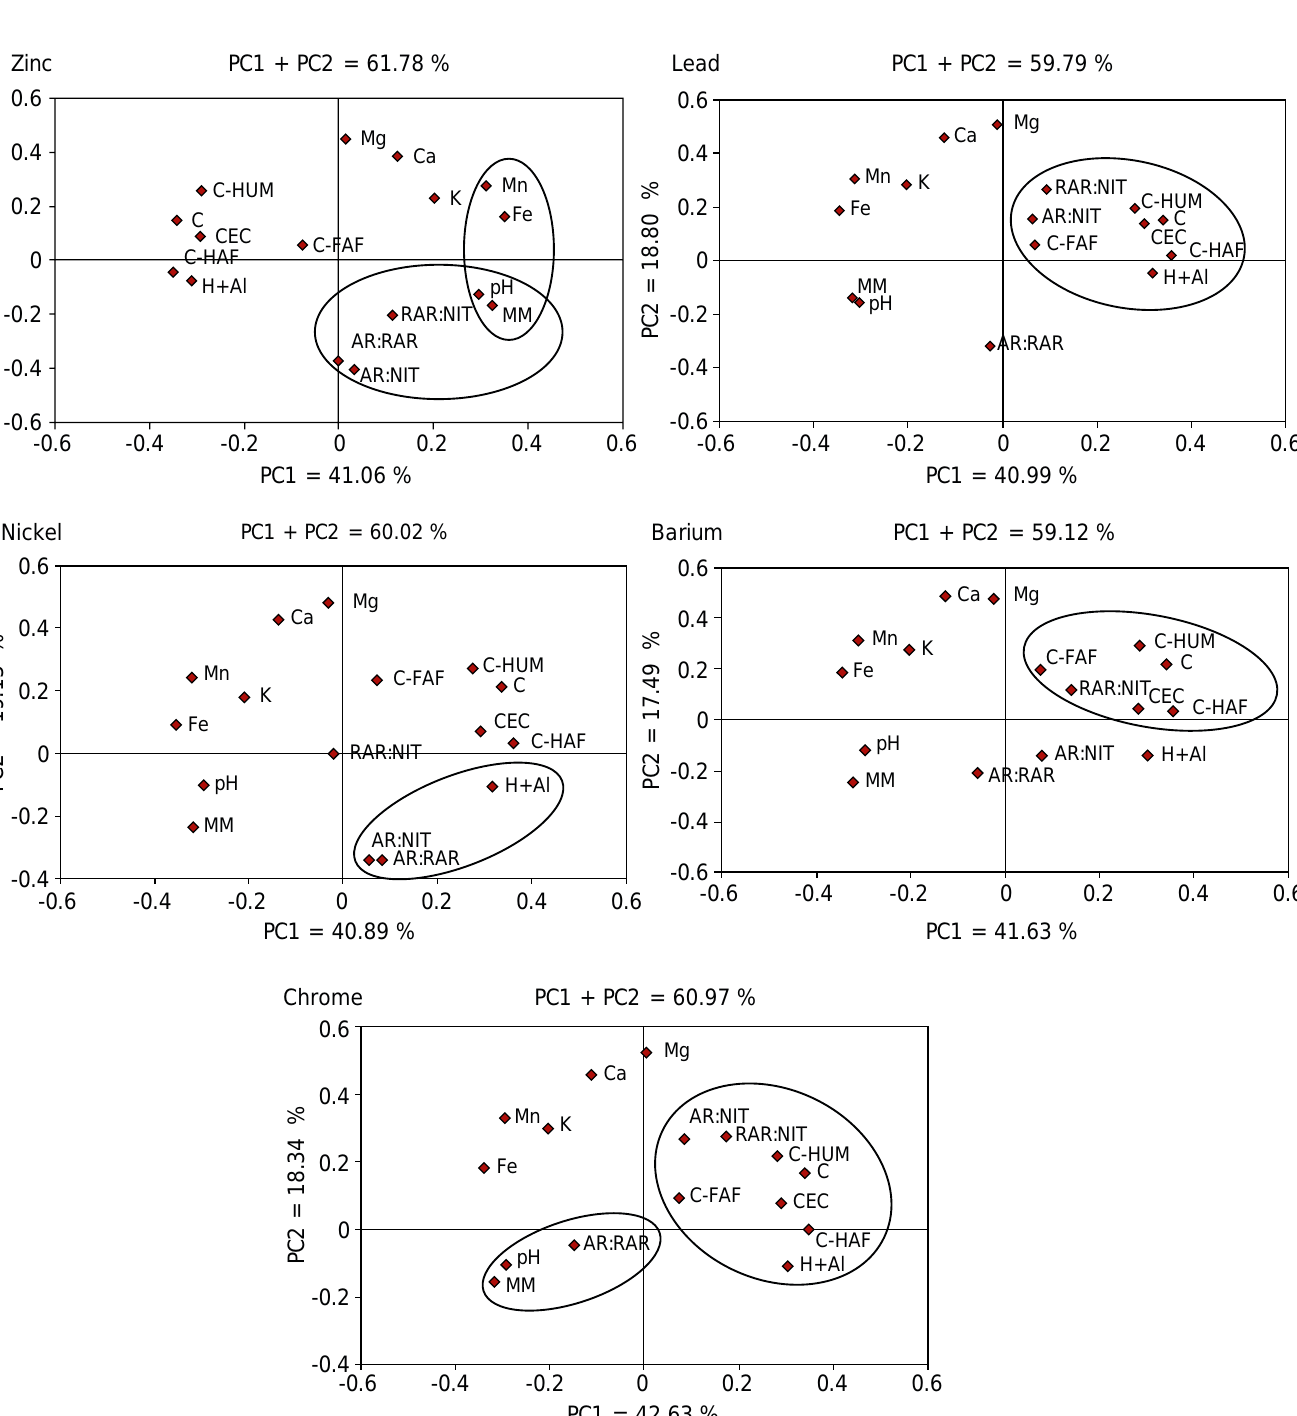
Figure 2. Principal components 1 and 2, for variation rates of the levels of metals between the methods and the properties of organic horizons. H+Al: acidity potential; CEC: cation exchange capacity at pH 7.0; MM: mineral matter, C: carbon determined by CHN analysis; C-FAF: carbon in the fulvic acid fraction; C-HAF: carbon in the humic acid fraction; C-HUM: carbon in the humin